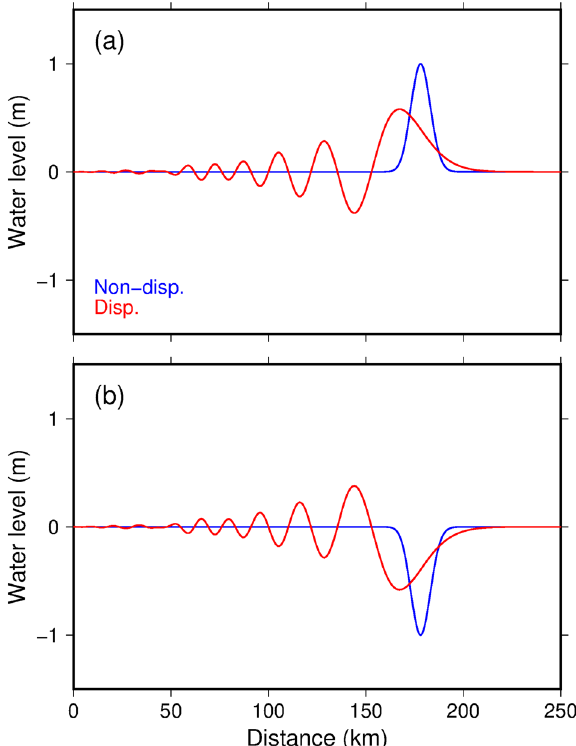
Figure 1. Non-dispersive (blue) and dispersive (red) propagation of Gaussian soliton wave shapes. ( a ) A positive (upwardly convex) incident wave. ( b ) A negative (downwardly convex) incident wave. The waves propagate in the horizontal direction over a water depth of 4000 m. Dispersion creates wave trains and increases the wave height in ( b ). Movie S1 shows propagations of the